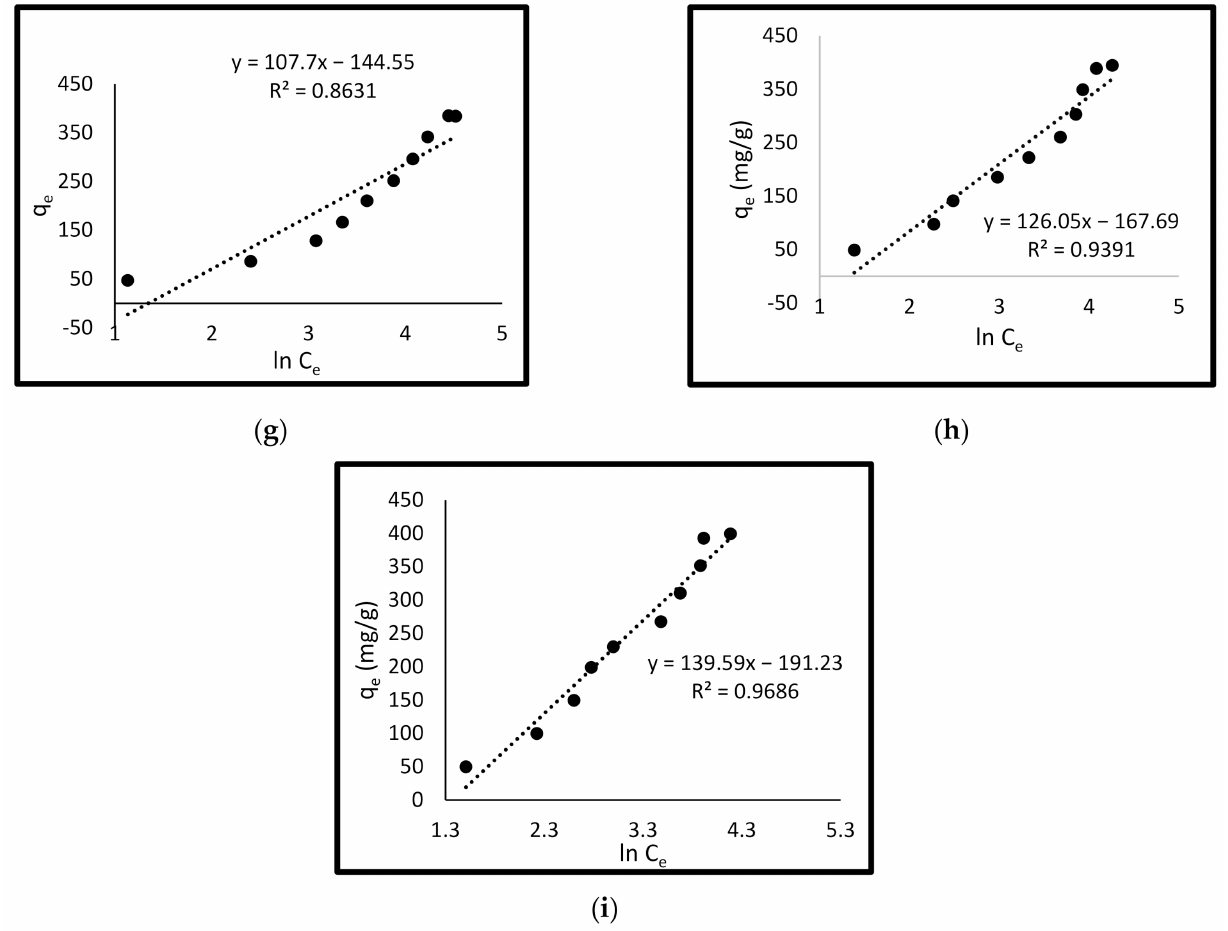
Figure 10. Adsorption isotherm models. ( a ) Langmuir isotherm at 293 K. ( b ) Langmuir isotherm. ( c ) Langmuir isotherm. ( d ) Freundlich isotherm. ( e ) Freundlich isotherm. ( f ) Freundlich isotherm. ( g ) Temkin isotherm. ( h ) Temkin isotherm. ( i ) Temkin isotherm.